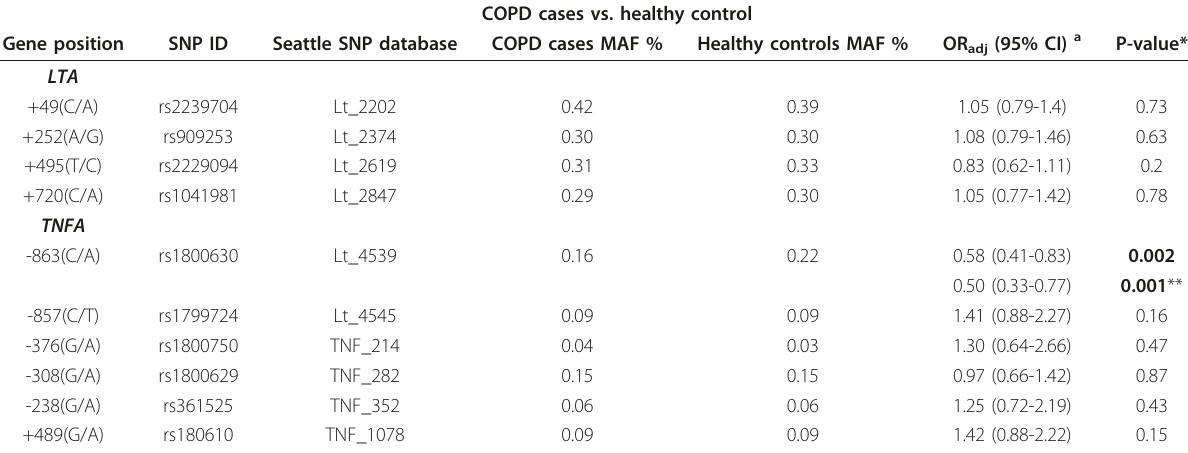
Table 2 Association of SNPs in the LTA and TNFA genes with Chronic Obstructive Pulmonary Disease (COPD) COPD cases vs. healthy control